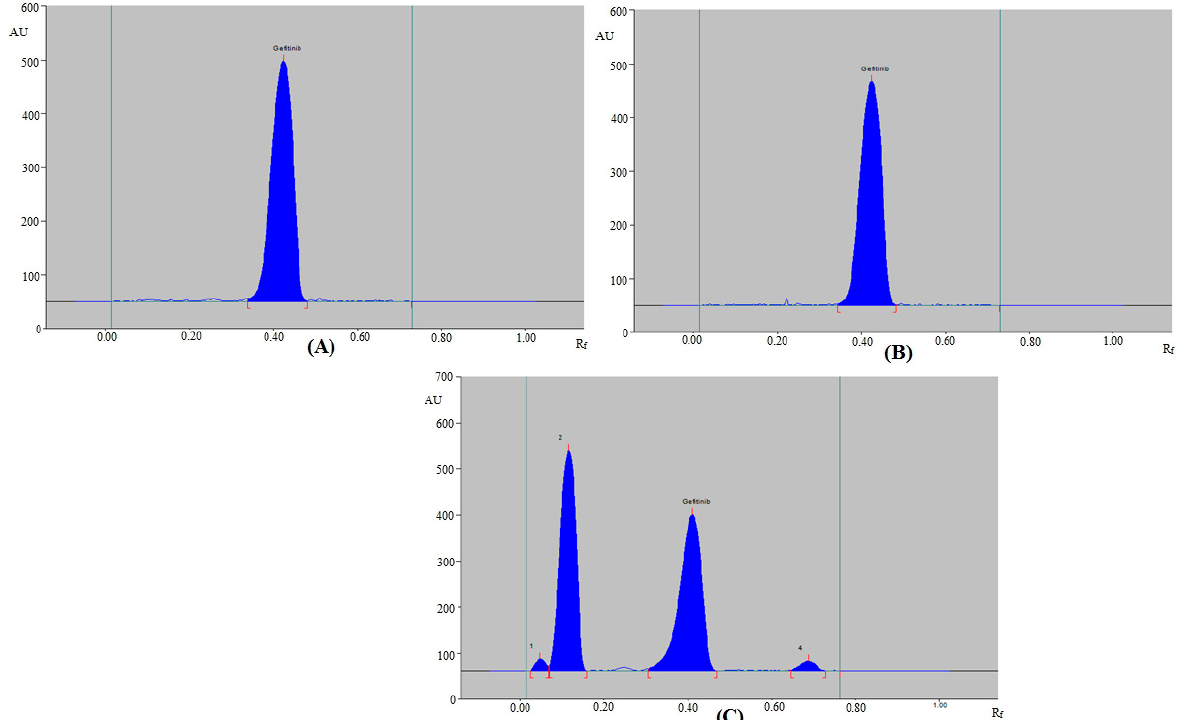
Figure 4. HPTLC densitograms of GFT obtained under ( A ) acid degradation, ( B ) base degradation, and ( C ) oxidative degradation of GFT using the greener HPTLC method .